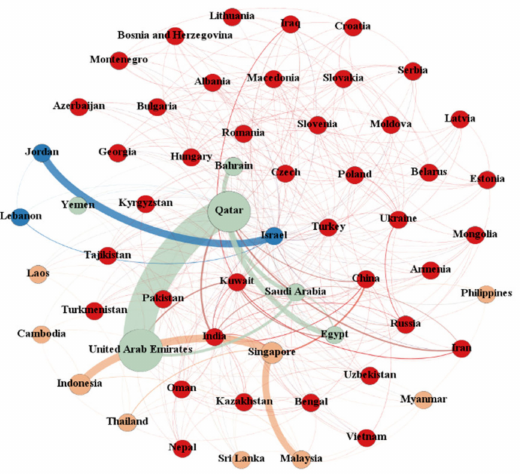
Figure 6. Energy space network of Belt and Road countries in 2016. Betweenness centrality reflects the role of bridges. The average intermediary centrality in 2003 was 87.53, and there were 17 countries above the average. According to